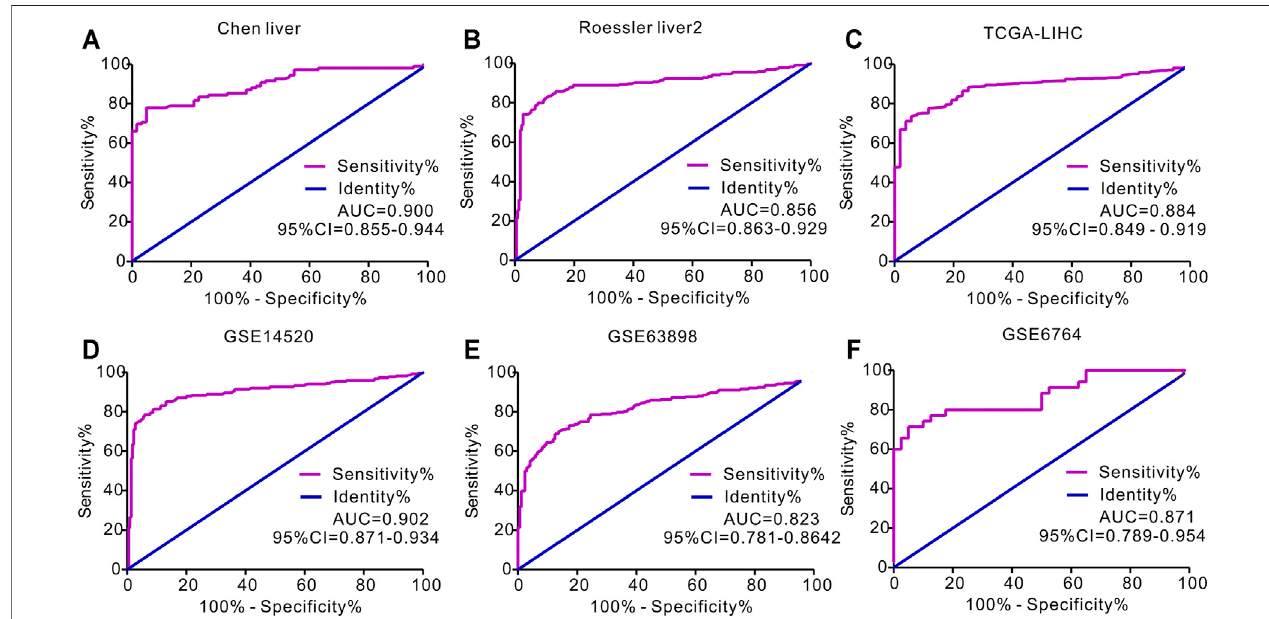
FIGURE3| Receiver operatingcharacteristics(ROC) curve forAPOA-1mRNAexpression inpredictingHCC. ROCcurve ofAPOA-1 in (A) Chenliver, (B) Roessler liver 2, (C) TCGA-LIHC, (D) GSE14520, (E) GSE63898, and (F) GSE6764.